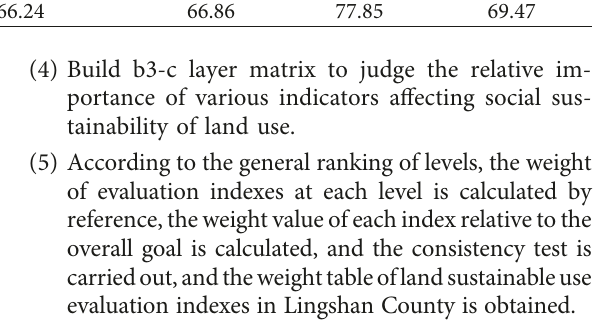
Table 12: Evaluation results of sustainable land use. Ecological